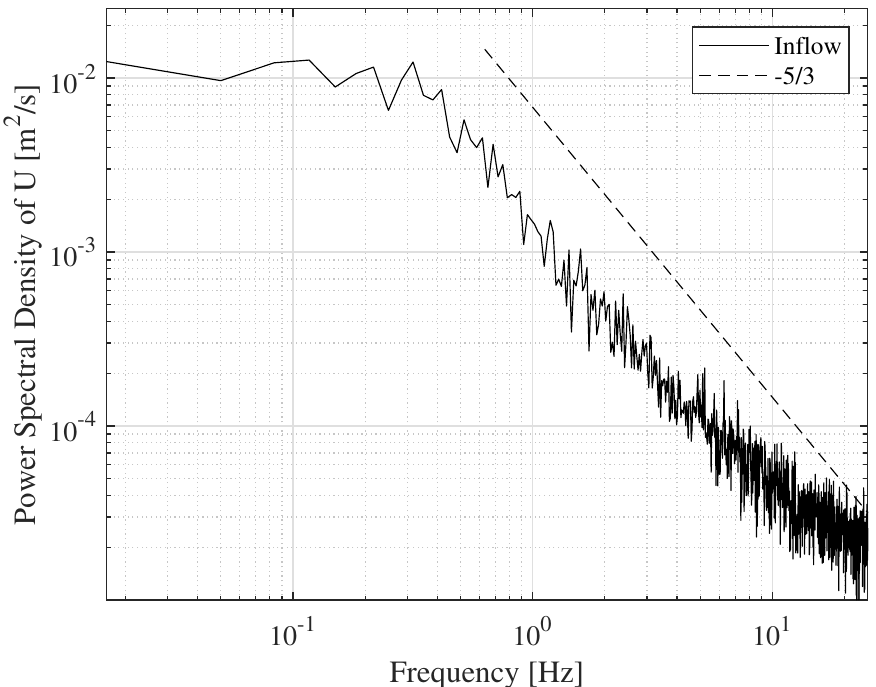
Figure 5. The hub height, centerline spectrum of the streamwise component of the inflow recorded by